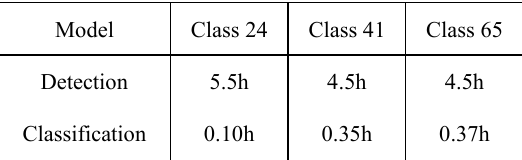
Table 2. The training time of detection model and classification model in DN detection